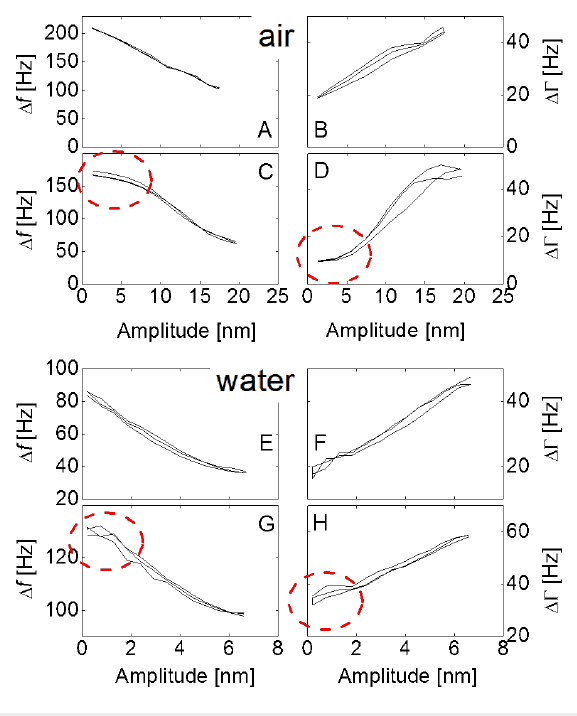
Figure 4: Data traces of frequency shift, Δ f , and bandwidth shift, ΔΓ , versus amplitude of oscillation. All data sets contain four amplitude sweeps. Data shown in the four panels at the top and the four panels at the bottom were acquired in air and in water, respectively. In liquids, the maximum achievable amplitude is lower than in air because of damping. Δ f and ΔΓ decrease and increase with amplitude, respective- ly, as is characteristic for partial slip. Panels A, B, E, and F show typical data traces. In these cases, the amplitude dependence is linear. Occasionally, one also finds plateaus at small amplitudes (dashed ellipses in panels C, D, G, and H). In these cases, the edge of the con- tact sticks at small amplitudes, where the exact conditions, under which such a stick occurs, are unclear. Even in these cases, the frequency–amplitude traces are clearly not parabolic (which should result if the Savkoor model was